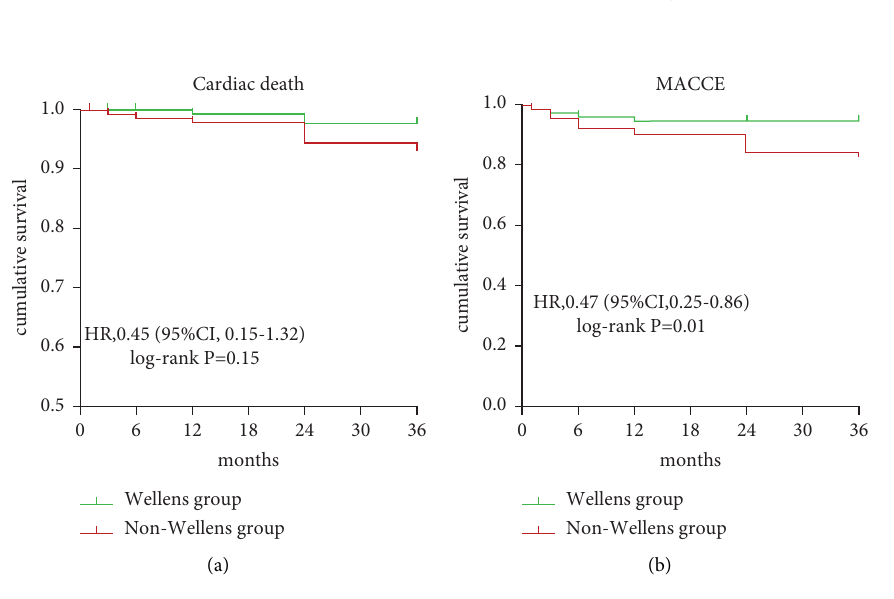
Figure 2: Kaplan–Meier analysis of MACCE (a) and cardiac death (b) for overall patients stratifed by Wellens’ syndrome (green line) and non-Wellens’ syndrome (red